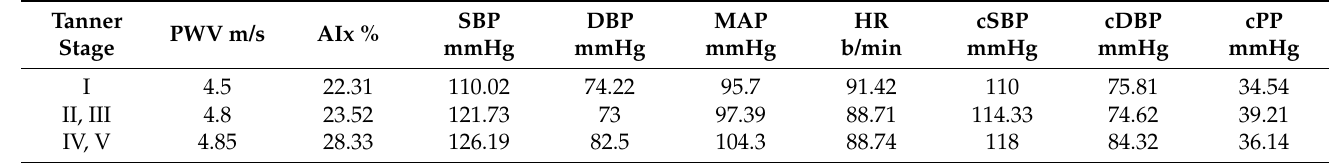
Table 9. Mean and medians of PWA parameters for the obese patients, by Tanner